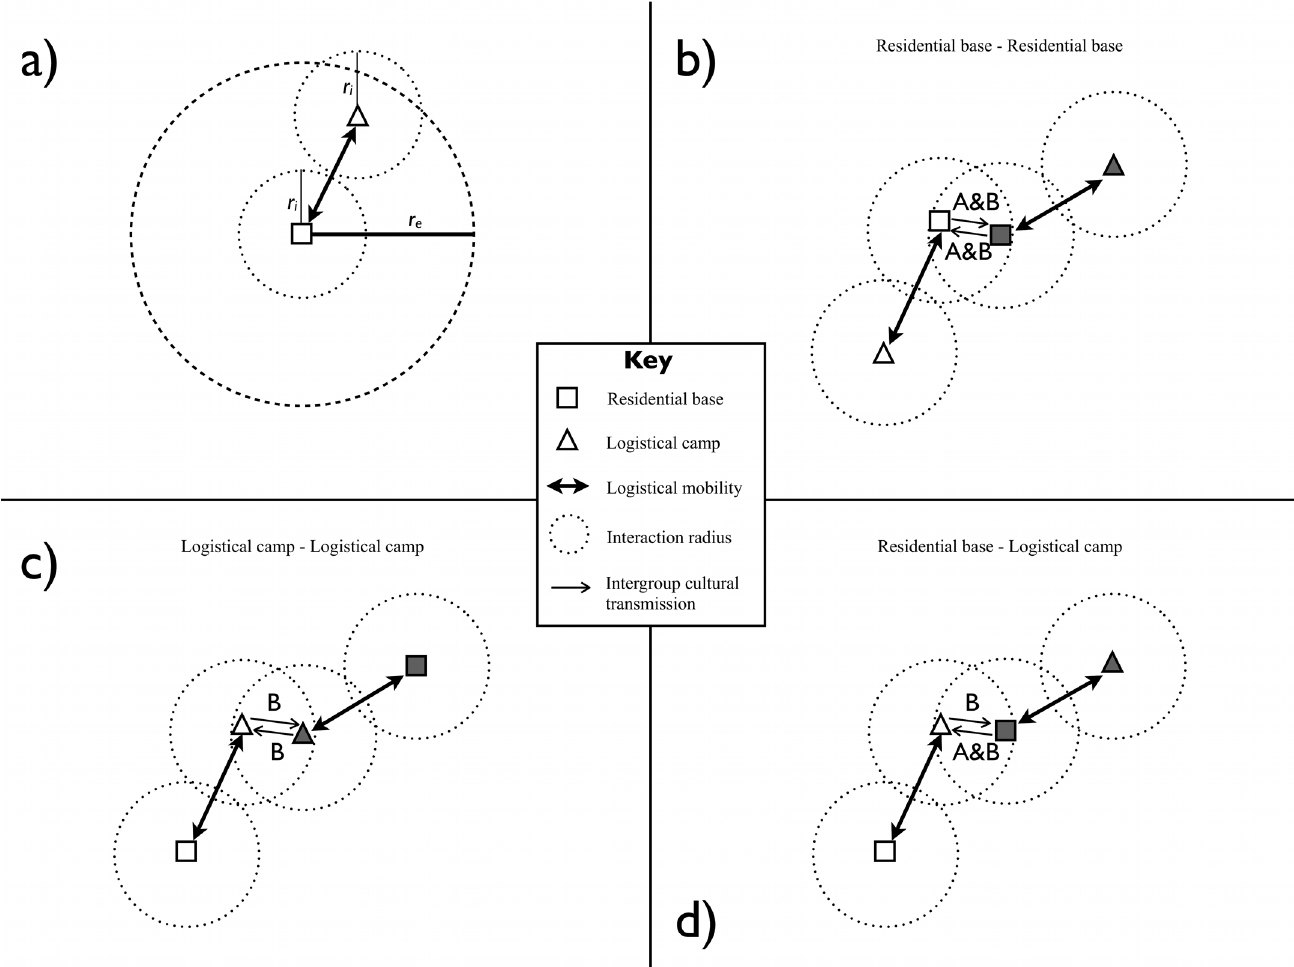
Fig 1. A simple model of central-place foraging and cultural transmission of two traits that differ in taskscape visibility. Each foraging group conducts logistical forays within distance r e of its residential base (a) until the foraging area is depleted of resources. Cultural transmission occurs between groups that find themselves within distance r i of one another during the normal course of foraging. These encounters can occur between two residential bases (b), between two logistical camps (c), or between a residential base and a logistical camp (d). Whether the teacher is observed at its residential base or logistical camp determines which trait(s) the learner is able to acquire via oblique cultural